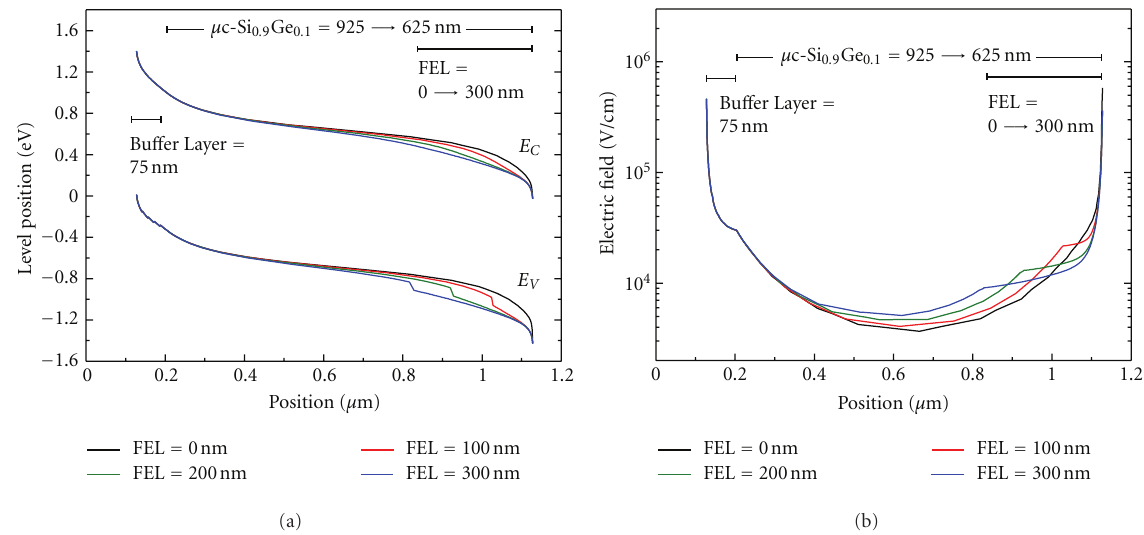
Figure 5: (a) The band diagram and (b) the electric field in the main layer of the solar cell with di ff erent μ c-Si:H FEL in thermodynamic